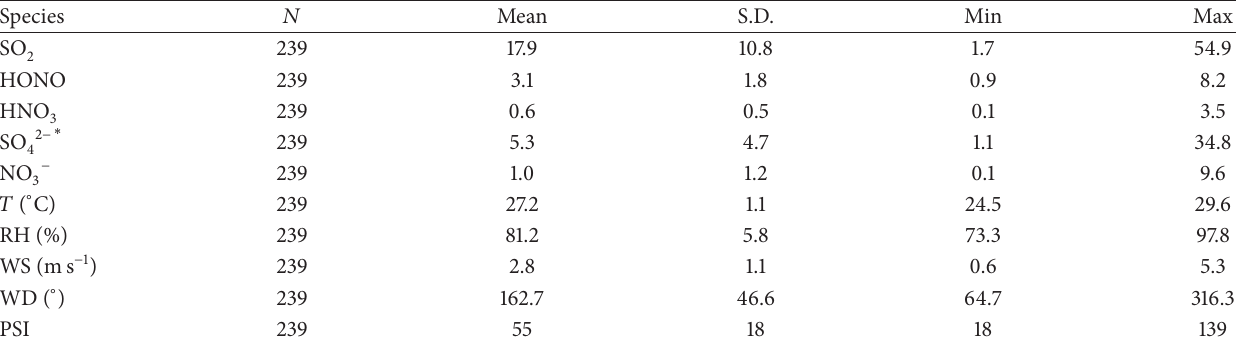
Table 1: Statistical summary of air quality (unit: 𝜇 gm − 3 ), meteorology, and PSI on a 24 hr basis.